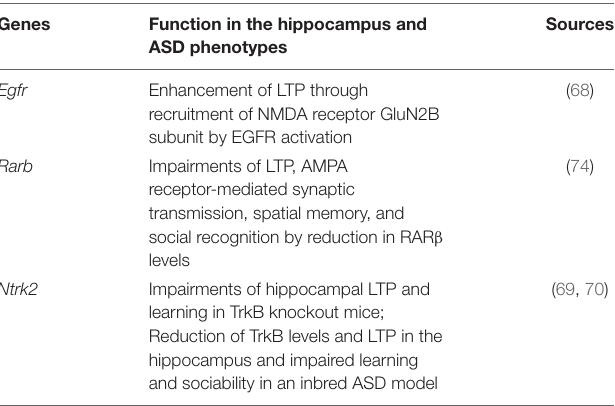
TABLE 1 | Relationship of the predicted genes to hippocampal function and ASD-like behaviors.